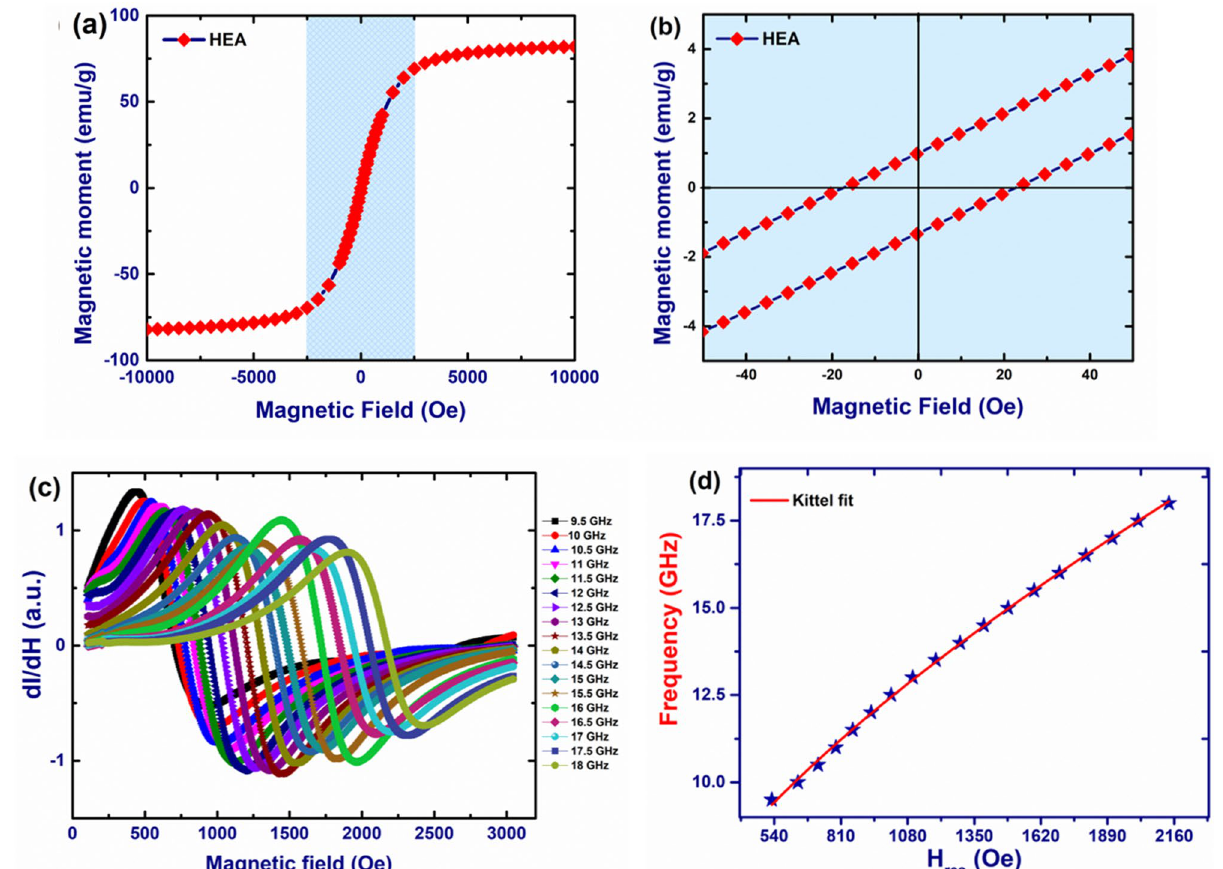
Figure 5. Magnetic properties of HEA thin films ( a ) the hysteresis loop (MH curve obtained from VSM at room temperature) ( b ) magnified hysteresis ( c ) FMR response of HEA thin films at various frequencies (d) Kittel